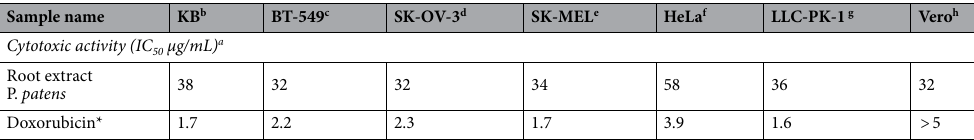
Table 1. Cytotoxicity activities of P. patens methanolic extracts from roots towards a panel of mammalian cell lines. a IC